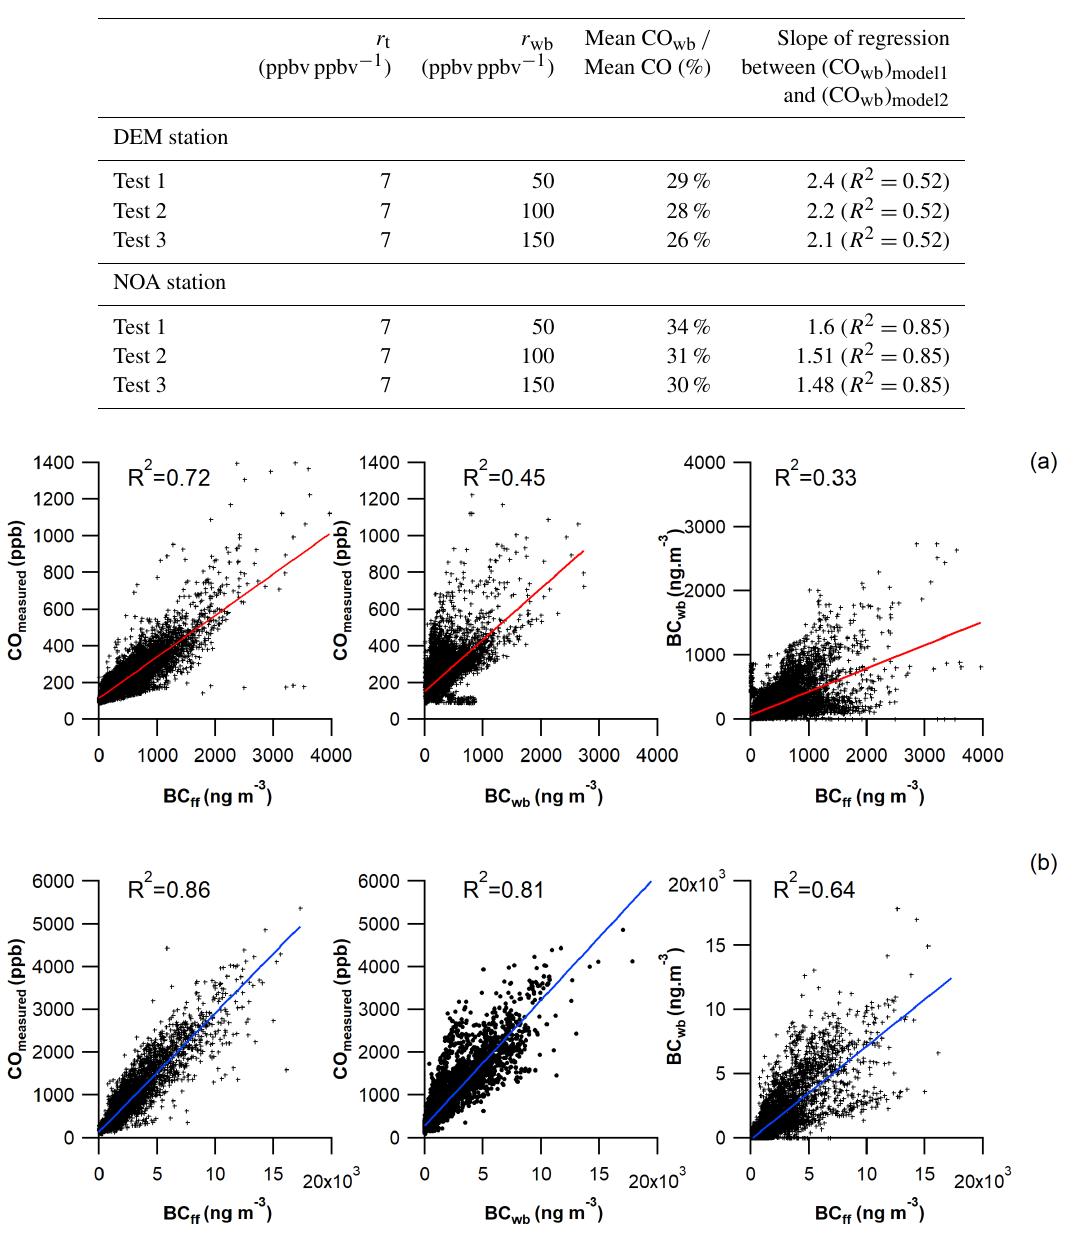
Table 4. Sensitivity test of the CO–NO x linear model for a constant emission ratio for traffic ( r t ) and a variable emission ratio for wood burning and comparison of model 1 (linear) versus model 2 (multilinear).